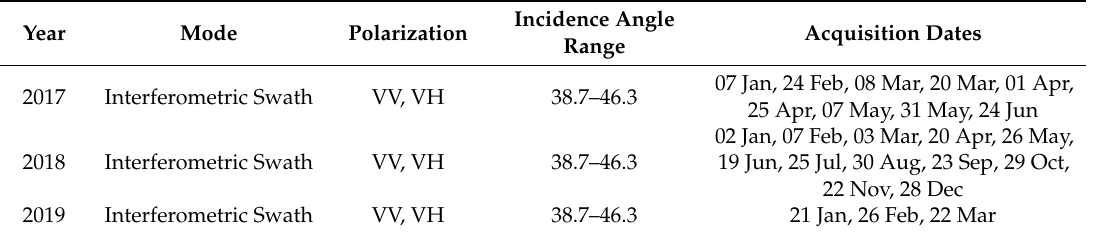
Table 1. Sentinel-1 SLC data used in the Grand Mesa, Colorado study region.